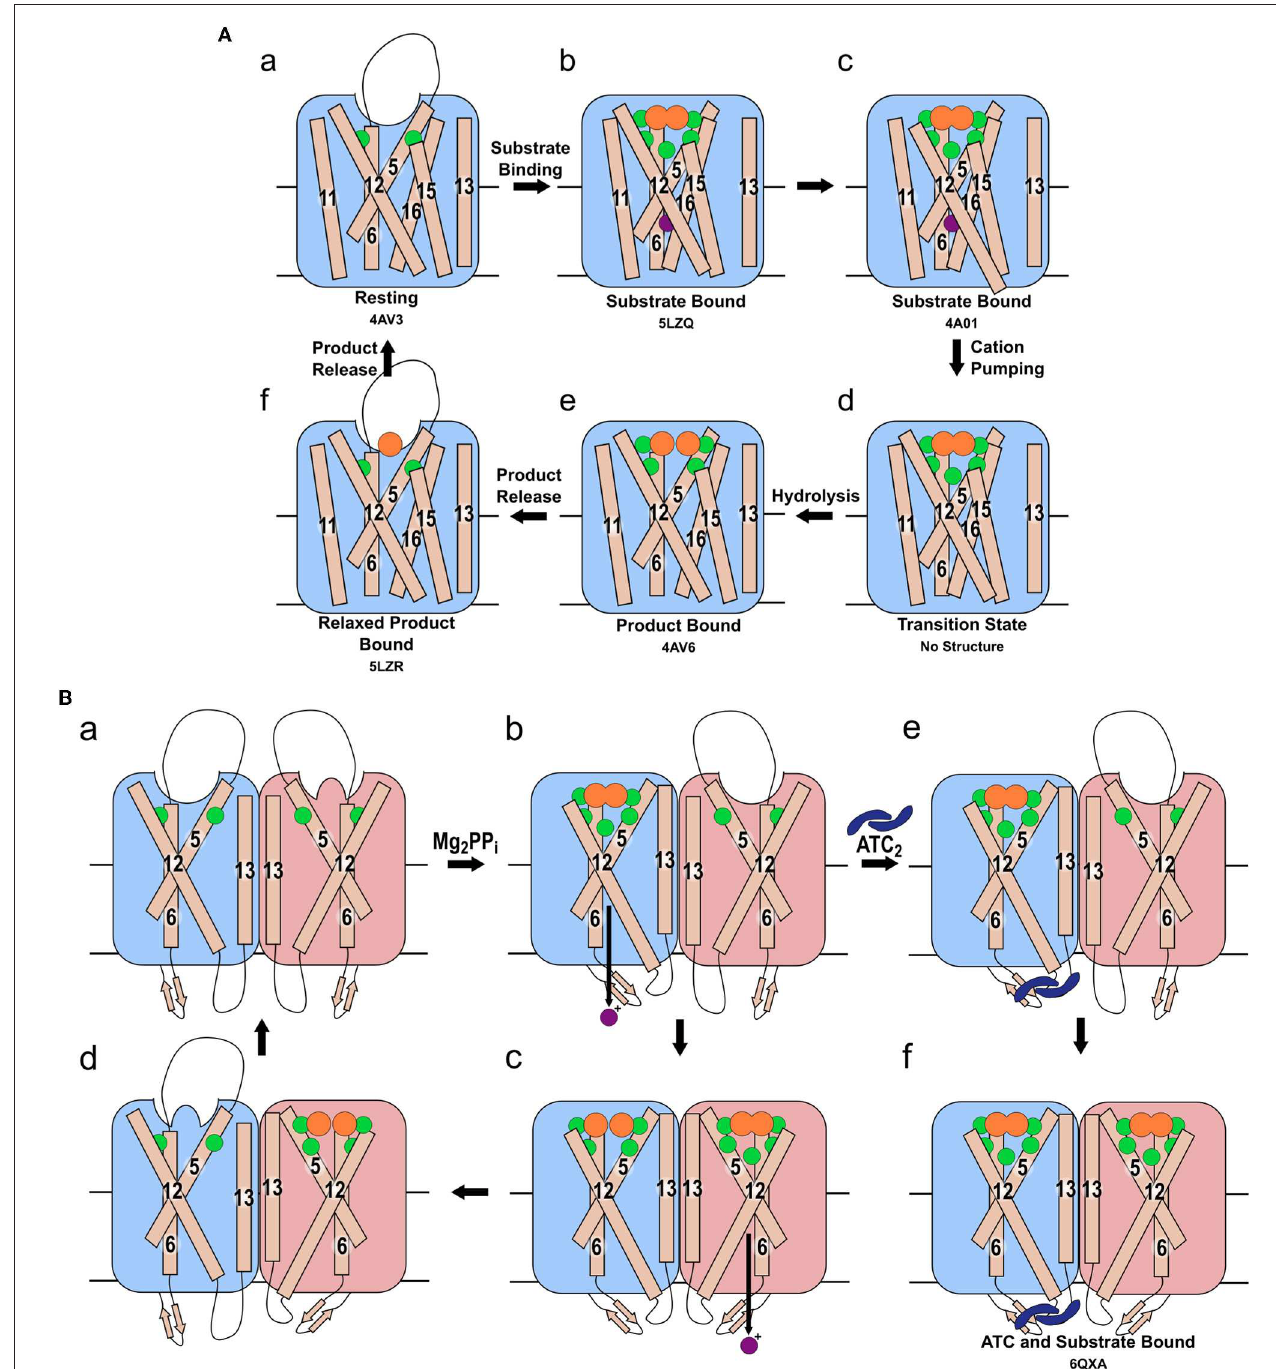
FIGURE 2 | Mechanism of pumping and hydrolysis. (A) “Binding change” mechanism. In the resting state (a), a cation may be present, but its position has not been revealed structurally. When substrate binds, the hydrolytic center is occluded by movement of the 5-6 loop and of TMH 11-12 and 15-16, and a cation localizes to the ionic gate (b). The cation is then pumped (c) and TMH 12 resumes its original position (d). Hydrolysis then occurs (e). Prior to the sequential release of the product P i , the 5-6 loop, TMH 11-12 and 15-16 relax to their resting positions (f). (B) The proposed asymmetric cycle of the mPPase dimer. One site is capable of binding PP i , while the other is distorted (a). Upon binding of one PP i molecule and ion pumping, the other site undergoes a conformational change, triggered by the movement of TMH13, to increase its affinity for PP i (b). The second PP i molecule binds and the second cation is pumped, while the first PP i is hydrolyzed (c). Upon release of the resulting P i , this active site is distorted to reduce affinity for PP i whilst the second bound PP i undergoes hydrolysis (d). States (e,f): the proposed result of allosteric inhibitor ATC binding to the mPPase. The dimer is trapped in a state unable to hydrolyze PP i , but capable of binding one (e) or two (f) PP i . (Green spheres: Mg 2 + , purple spheres: cation for pumping, orange spheres: PP i or PO 4 , blue dimeric shape: ATC). PDB IDs for structurally defined states are listed beneath the relevant image.